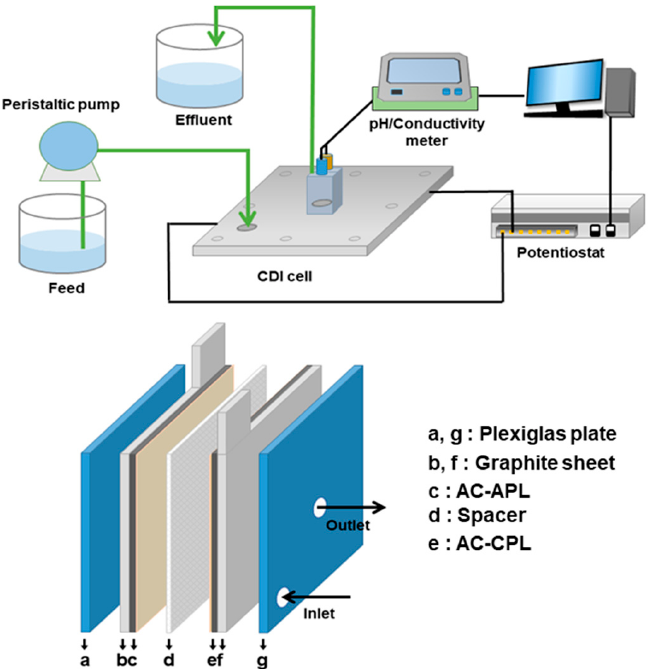
Figure 1. Schematic diagram of the MCDI experiment and cell configuration.